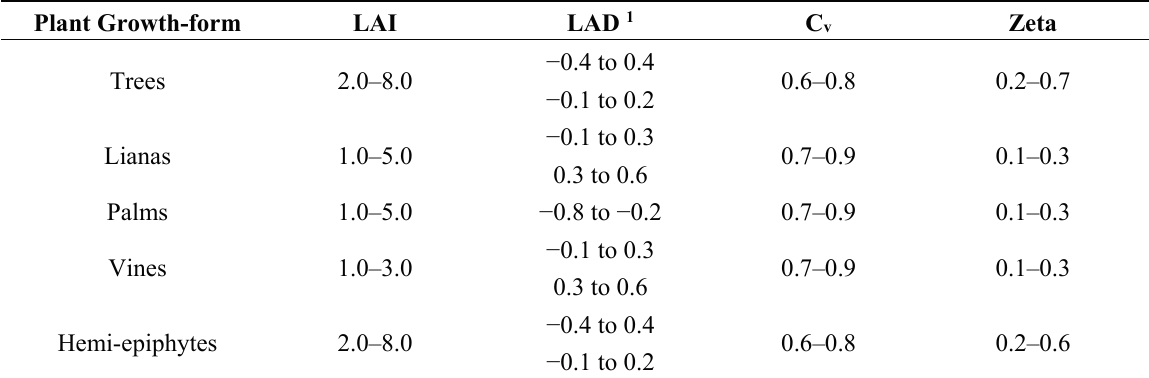
Table 2. Ranges of canopy structural parameters randomly selected during canopy radiative transfer model simulations. LAI = leaf area index; LAD = leaf angle distribution; C v = crown covering the ground at nadir; Zeta = ratio of crown diameter to tree height. The modeled LAI variation is considered extreme for tropical canopies